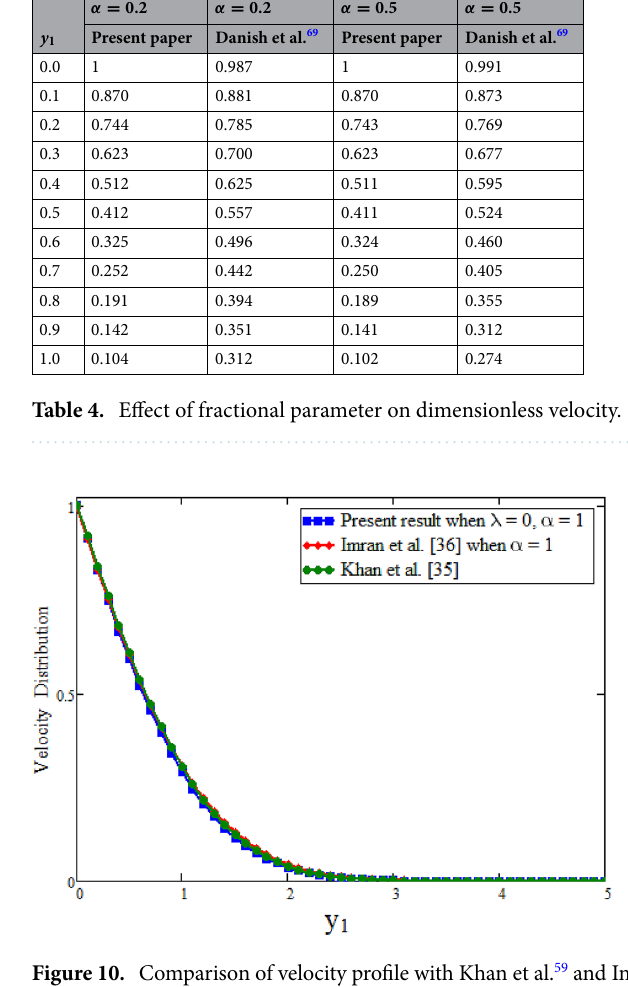
Figure 10. Comparison of velocity profile with Khan et al. 59 and Imran et al. 61 , when: t = 0.095 , φ = 0.72 , Pr = 6.2 and Gr =